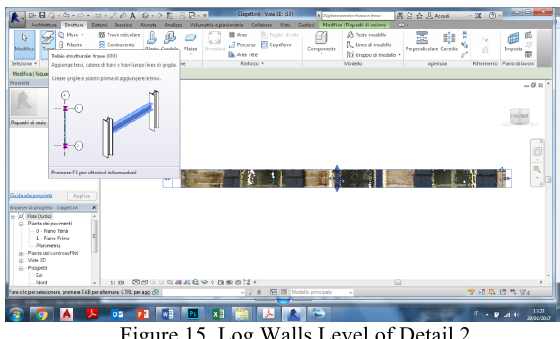
Figure 15. Log Walls Level of Detail 2